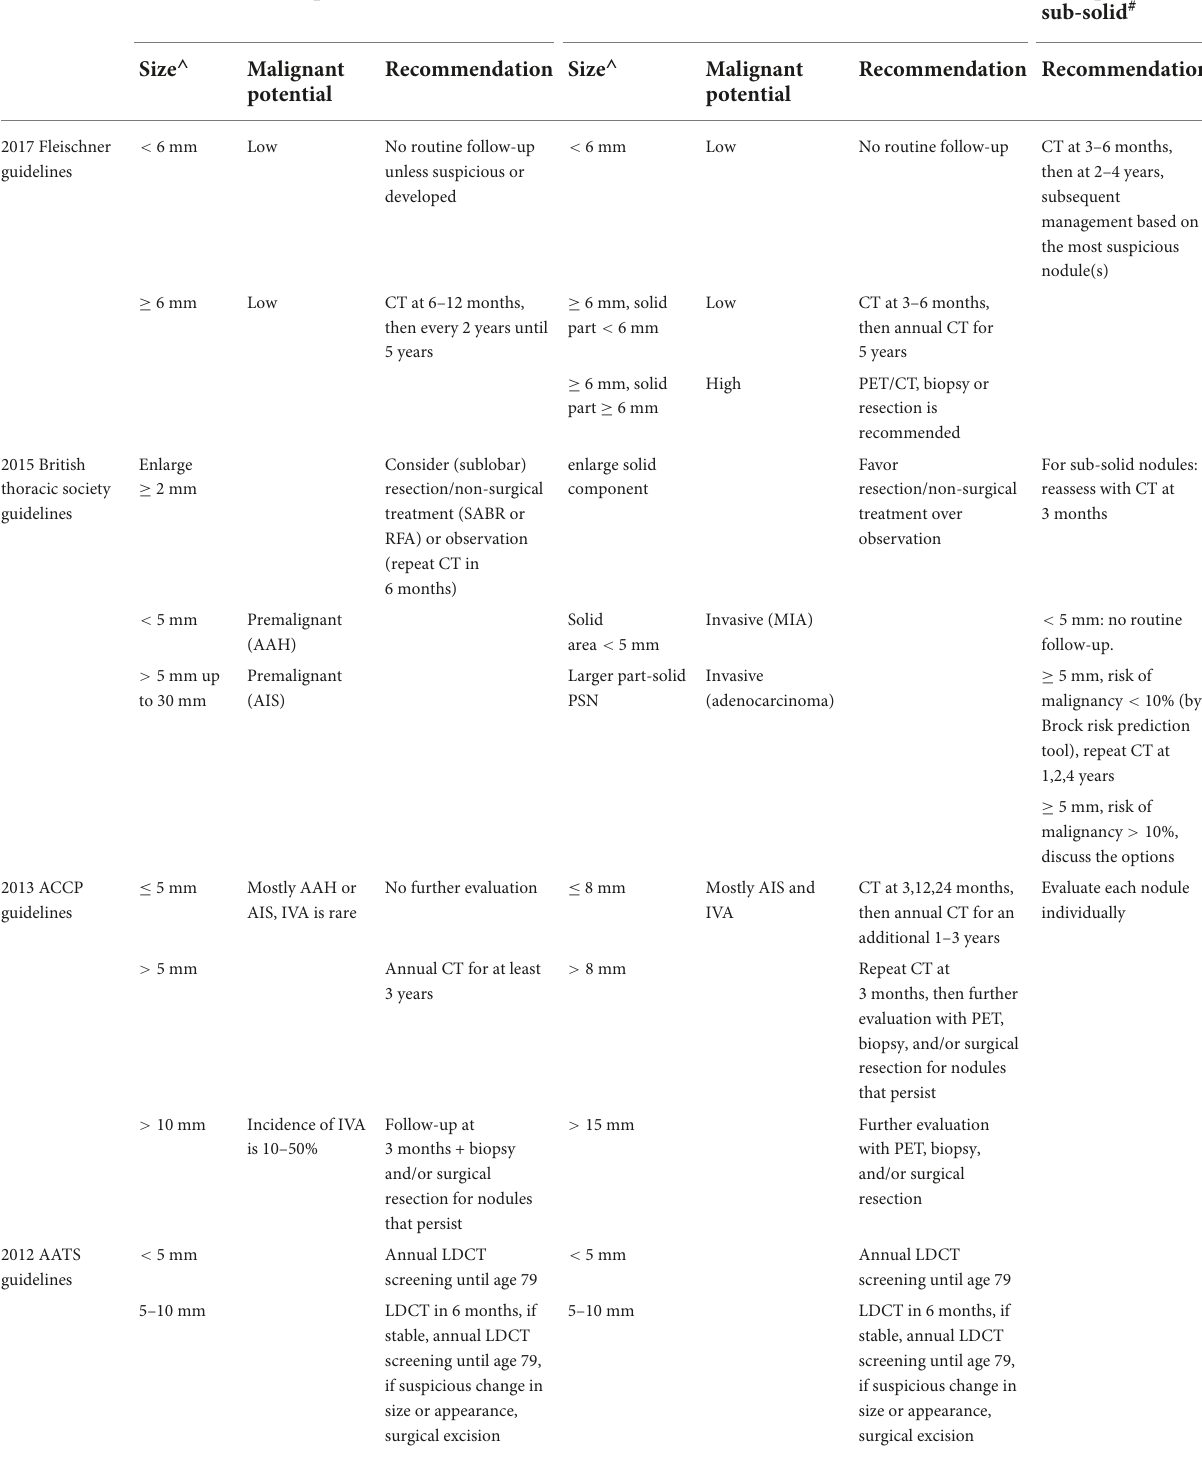
TABLE 2 Follow-up recommendations of GGNs from different